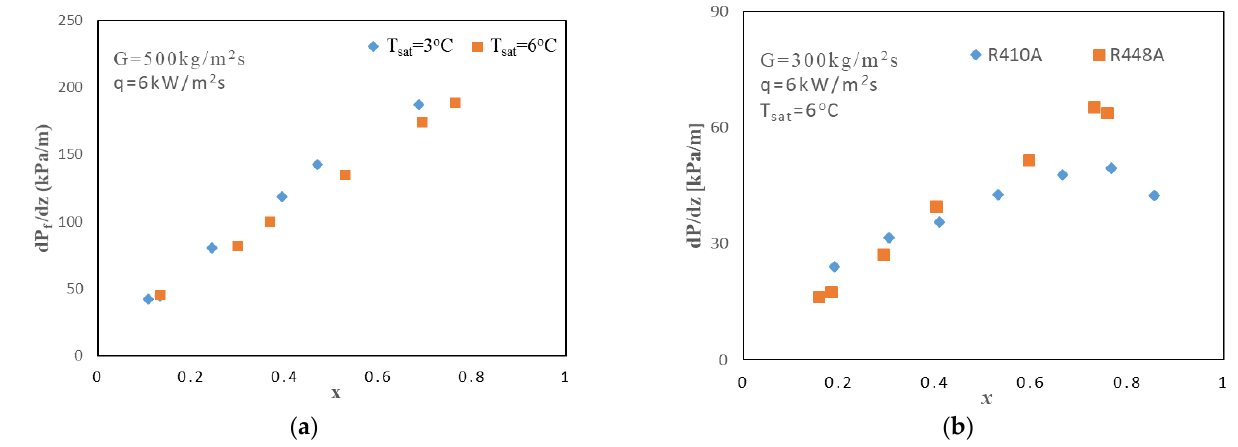
( b ) Figure 8. Effect of ( a ) mass flux and ( b ) heat flux on pressure drop. The pressure drop significantly increased with an increase in the mass flux and va- por quality, as shown in Figure 8a. Mass flux played a similar role toward pressure drop like heat transfer coefficient. The mass flux increased the initial pressure gradient (base- line) at low quality and the slope of pressure gradient increased with an increase in the